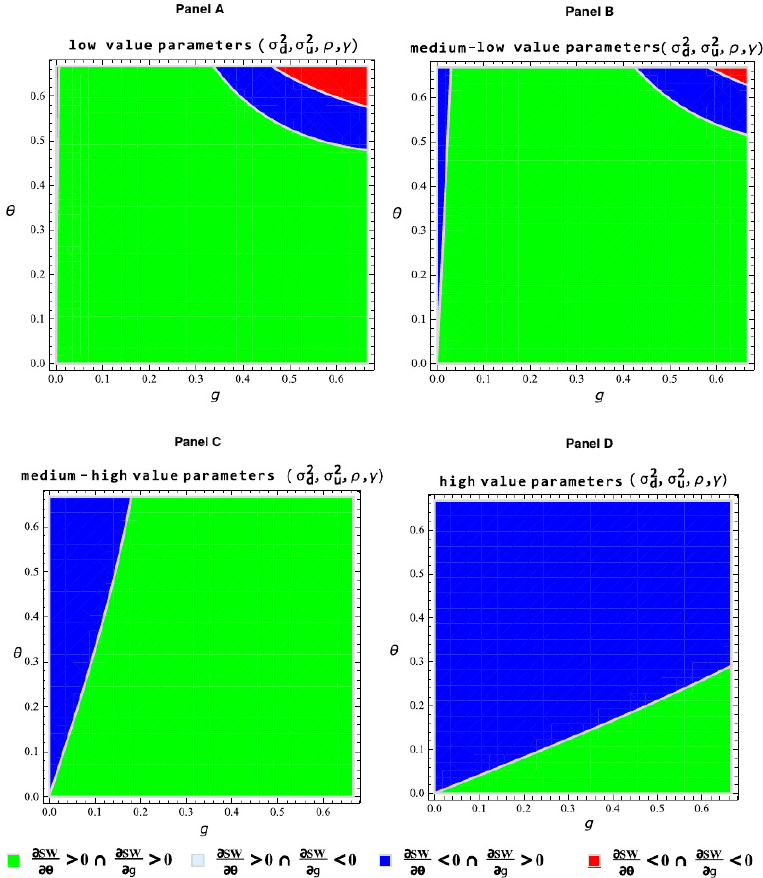
Figure 2. Impact of cross-group network externalities on the equilibrium level of social welfare for different values taken by parameters 𝜎 (cid:3031)(cid:2870) , 𝜎 (cid:3048)(cid:2870) , 𝛾 , and 𝜌 . Panel A captures the impact of both cross-group network externalities 𝜃 and 𝑔 on social welfare when parameters 𝜎 (cid:3031)(cid:2870) , 𝜎 (cid:3048)(cid:2870) , 𝛾 , and 𝜌 have low value. Panel A simulates the impact of both cross-group network externalities 𝜃 and 𝑔 when parameters 𝜎 (cid:3031)(cid:2870) , 𝜎 (cid:3048)(cid:2870) , 𝛾 , and 𝜌 have a low value. Panel B simulates the impact of both cross-group network externalities 𝜃 and 𝑔 on social welfare when parameters 𝜎 (cid:3031)(cid:2870) , 𝜎 (cid:3048)(cid:2870) , 𝛾 , and 𝜌 have a low-medium value. Panel C simulates the impact of both cross-group network externalities 𝜃 and 𝑔 on social welfare when parameters 𝜎 (cid:3031)(cid:2870) , 𝜎 (cid:3048)(cid:2870) , 𝛾 , and 𝜌 have a medium-high value. Panel D simulates the impact of both cross-group network externalities 𝜃 and 𝑔 on social welfare when parameters 𝜎 (cid:3031)(cid:2870) , 𝜎 (cid:3048)(cid:2870) , 𝛾 , and 𝜌 have a high value.